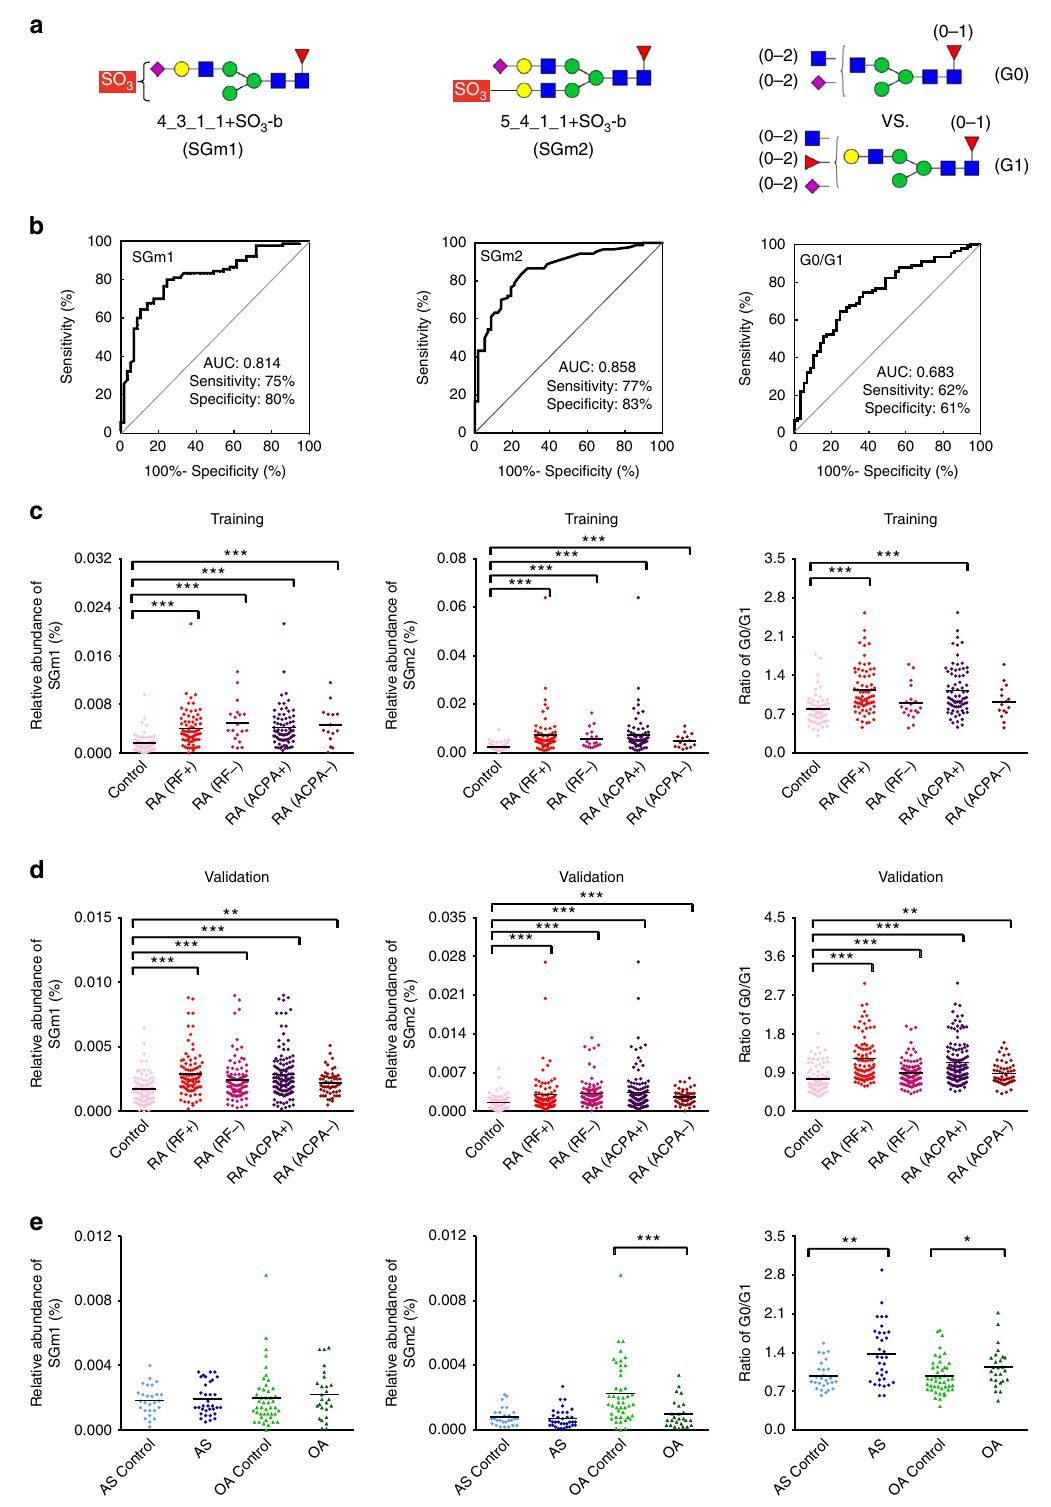
Fig. 7 Performance and relative abundances of the potential N-glycan biomarkers for RA. a Symbols depicting N-glycan biomarkers identi fi ed in current study (SGm1 and SGm2) and that reported previously (G0/G1). b The ROC curve of the biomarkers for the classi fi cation of RA ( n = 90) and healthy individuals ( n = 57). The results are plotted for the training set. c , d The scatter plot of the relative abundance of the N-glycan biomarker in control individuals (training set: n = 57, validation set: n = 84), RF-positive [RA (RF+)] (training set: n = 71, validation set: n = 90) and RF-negative [RA (RF − )] RA patients (training set: n = 19, validation set: n = 97), as well as ACPA-positive [RA (ACPA+)] (training set: n = 75, validation set: n = 132) and ACPA-negative [RA (ACPA − )] RA patients (training set: n = 15, validation set: n = 55), in training set and validation set. e The scatter plot of the relative abundance of the N-glycan biomarkers in AS patients ( n = 34), OA patients ( n = 26) and in controls of each (AS: n = 27, OA: n = 45). Horizontal lines indicate the median. Statistical analysis was performed by non-parametric Mann – Whitney test, two-sided (* P < 0.05, ** P < 0.01, *** P <